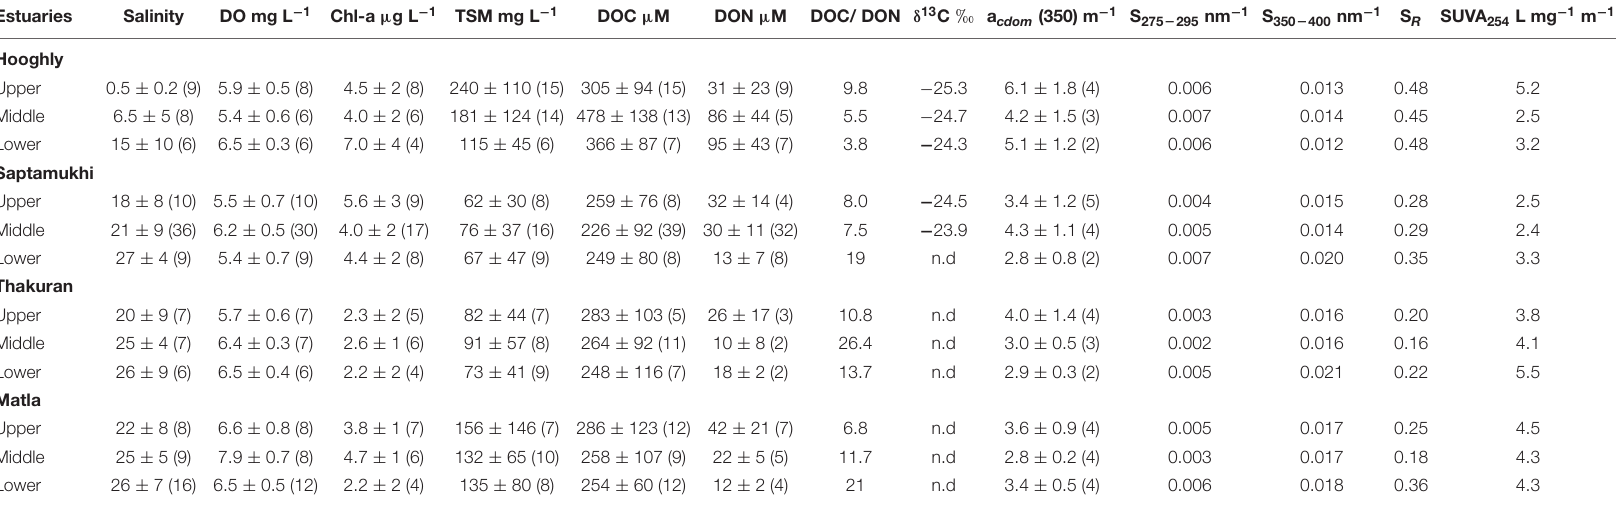
n = number of samples; these numbers varied among different parameters according to station locations and priorities in analytical measurements. The δ 13 DOC values were taken from Ray et al. (2015) (full data available as Supplementary Table S1 ). n.d. = no data